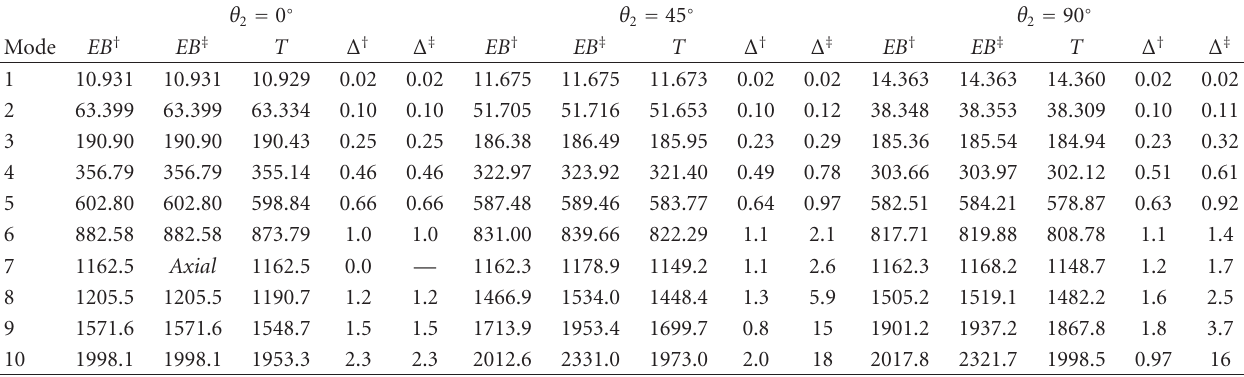
Table 4: First ten natural frequencies (Hz); two-link manipulator; ( L 1 /h = 33 . 33, L T /h = 69 . 33).